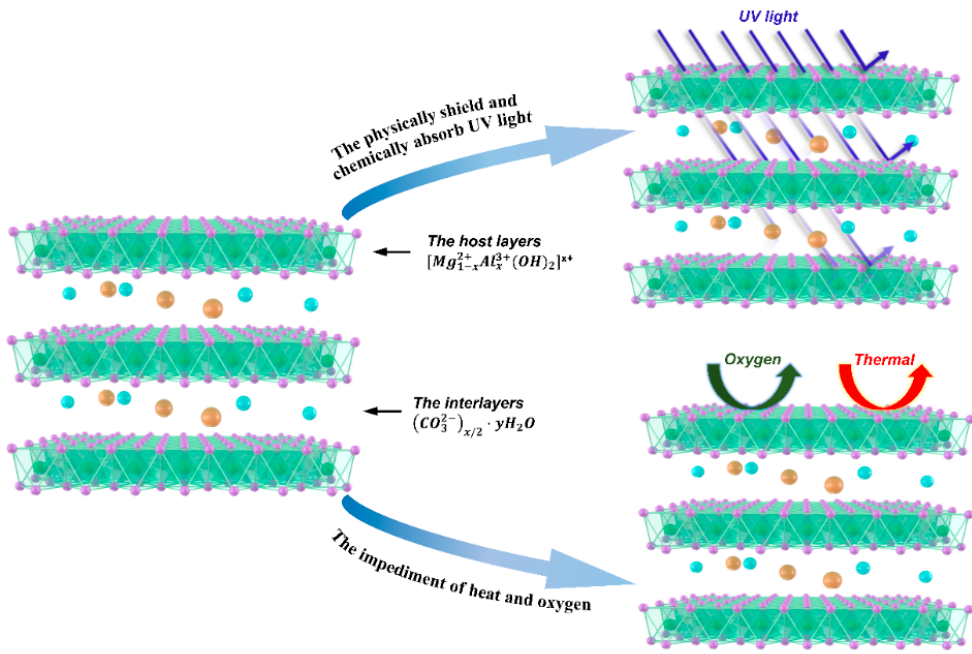
Figure 1. The mechanism of LDHs in improving the UV aging resistance and thermo-oxidative aging resistance.